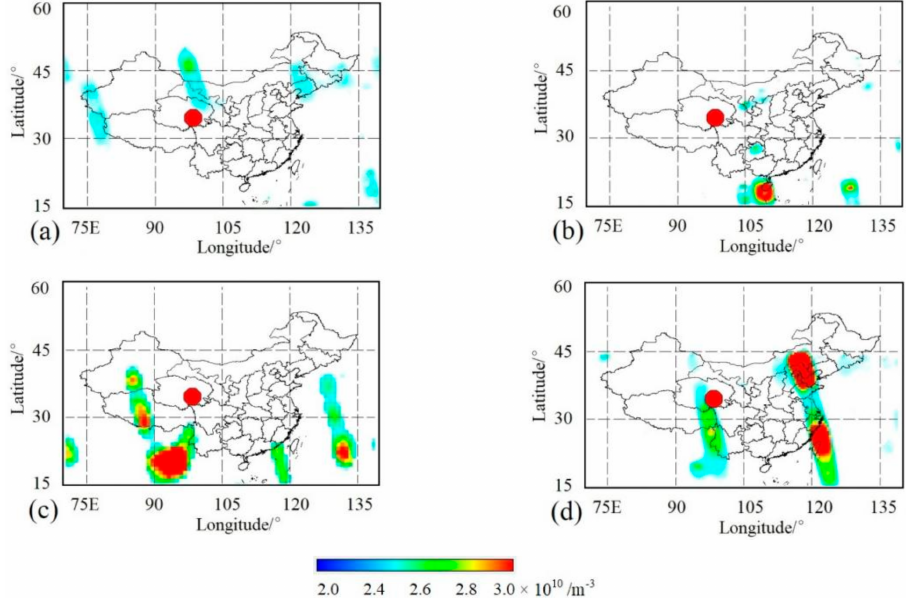
Figure 5. Variations in electron density during the periods of ( a ) April 28–May 4, ( b ) 5–11